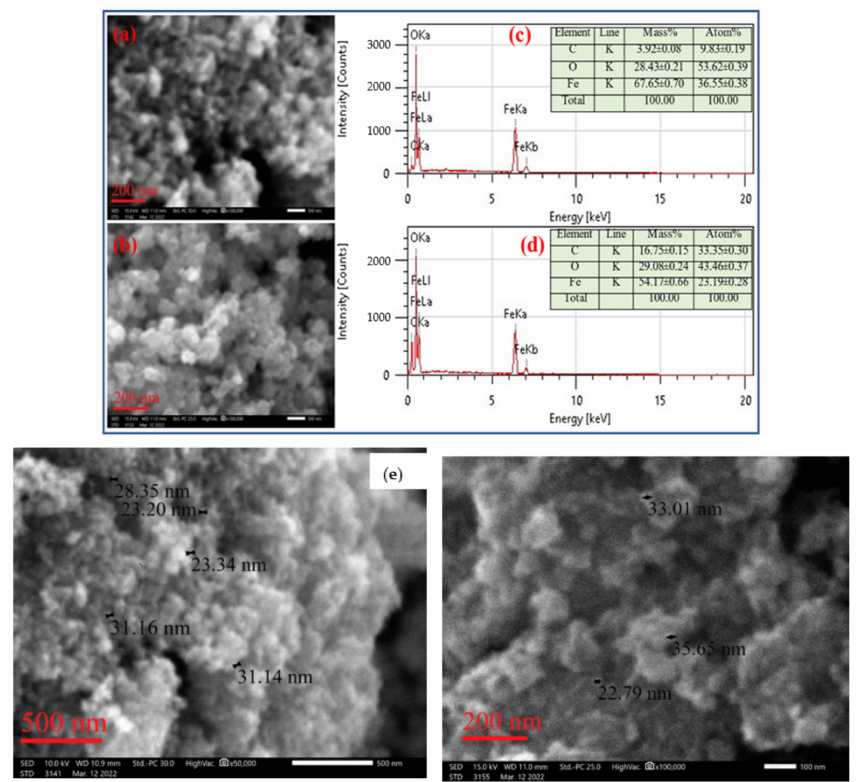
Figure 2. SEM graph for ( a ) Fe 3 O 4 @PSA, ( b ) Fe 3 O 4 @PSA-C nanoparticles, ( c ) EDX mapping of Fe 3 O 4 @PSA and ( d ) EDX mapping of Fe 3 O 4 @PSA-C, ( e ) SEM images of Fe 3 O 4 @PSA-C nanoparticles with grain size